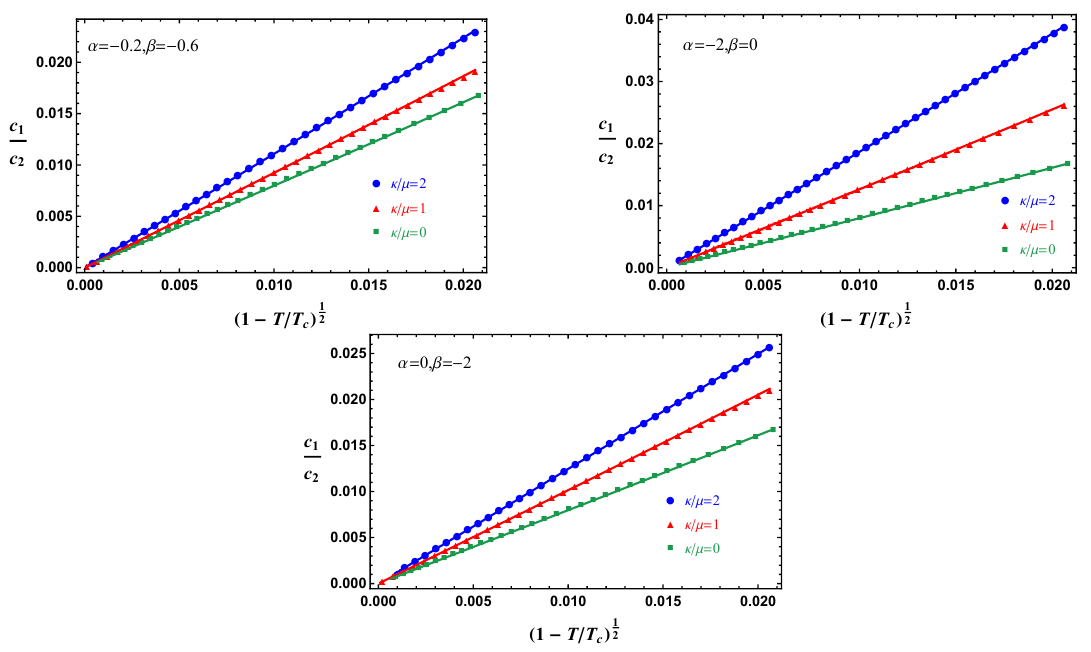
Figure 3 . The variation of c 1 /c 2 as a function of the temperature in various configurations of the massive gravity. The fitted straight lines for the data are determined by c 1 /c 2 = a (1 − T/T c ) 1 / 2 + b .